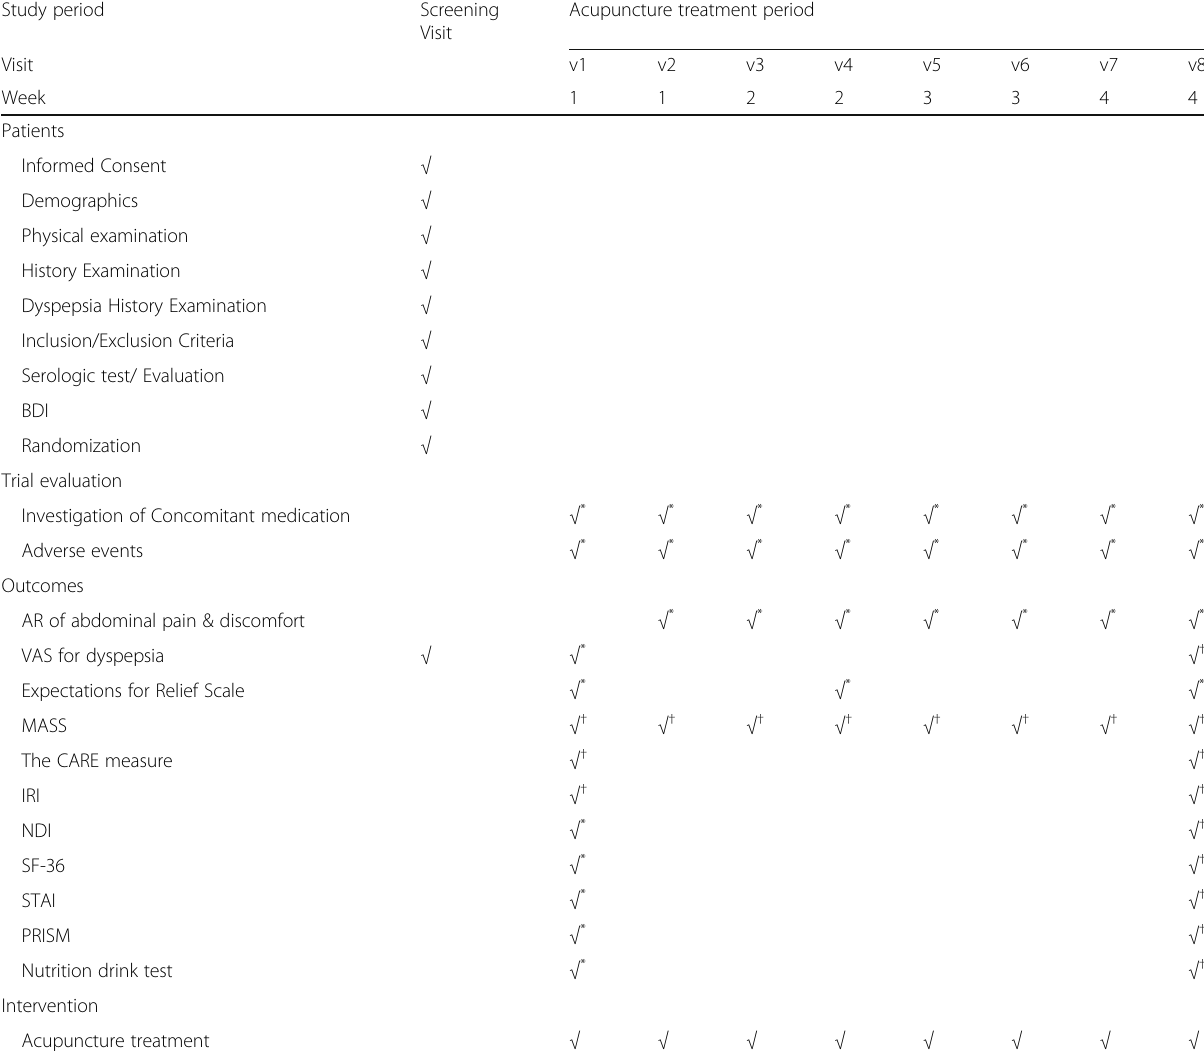
Table 3 The schedule of enrollment, intervention, and assessments Study